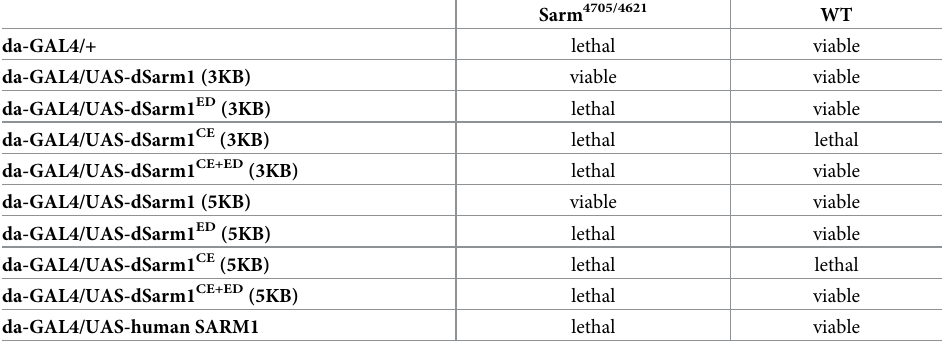
Table 1. Rescue Expression of dSarm1 transgenes rescue lethality of dSarm1 mutants. Daughterless-GAL4 (da- GAL4) was used to drive ubiquitous expression of Sarm1 transgenes. Homozygous dSarm1 4705 /dSarm1 4621 mutant ani- mals are lethal. Expression of transgenes in the mutant background tests for the ability of the transgene to rescue dSarm1 function. Expression of transgenes in a WT background tests for lethality of the transgene itself as is seen in the case of dSarm1 CE . Quantification is shown for each genotype as two sets of numbers 1) number of rescued mutant flies relative to control flies and 2) WT flies expressing transgene versus control flies). Quantification is as follows: da- GAL4/+ (0 mutant+transgene: 220 control and 144 WT+transgene: 66 control); da-GAL4/ dSarm1 (3KB) (166:73 and 171:159); da-GAL4/dSarm1 ED (3KB) (0:239 and 191:182); dSarm1 CE (3KB) (0:251 and 0:262); da-GAL4/dSarm1 CE+ED (3KB) (0:201 and 225:185); da-GAL4/dSarm1 (5KB) (204:63 and 90:243); da-GAL4/dSarm1 ED (5KB) (0:187 and 199:90); da-GAL4/dSarm1 CE (5KB) (0:164 and 0:195); da-GAL4/dSarm1 CE+ED (5KB) (0,153 and 185:206); da-GAL4/ human SARM1 (0,370 and